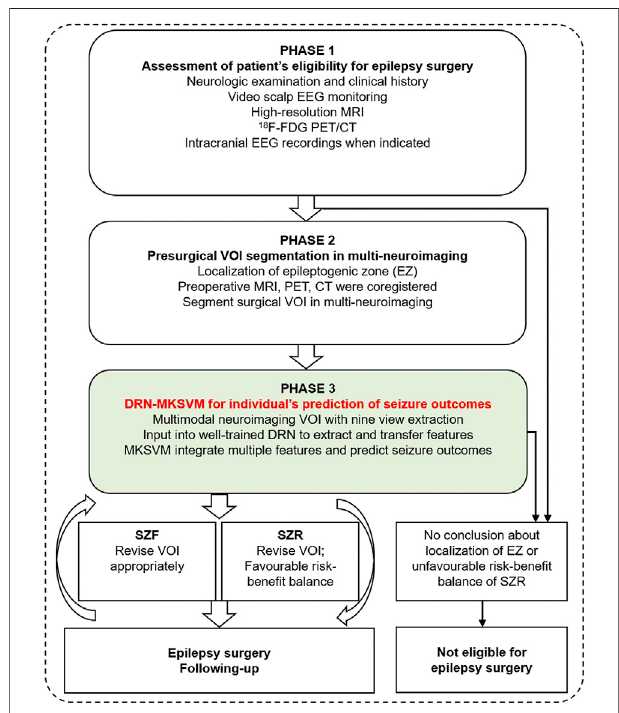
FIGURE 5 | Flow chart of DRN – MKSVM clinical application. Patient ’ s preoperativemulti-neuroimagingiscoregistered,andsurgicaltargetvolumeof interest(VOI)canbesegmentedduringpresurgicalassessment.Then,wecan obtain individualized prediction of seizure outcomes based on deep residual network and multi-kernel support vector machine (DRN – MKSVM) of multimodal neuroimaging VOI. presurgical VOI could be timely revised according to predicted results so that patients could avoid postoperative epilepsy recurrence and reduced complications caused by excessive lobectomy.Proposedmethodisobjective,automated,andfast.Bothpatients and epileptologists may bene fi t from optimizing VOI of surgery planning, objectiveandquanti fi ablepredictionofseizureoutcomes.Abbreviations:SZF, seizure-free(Engel classI); SZR, seizure-recurrence(Engel classIIthroughIV).